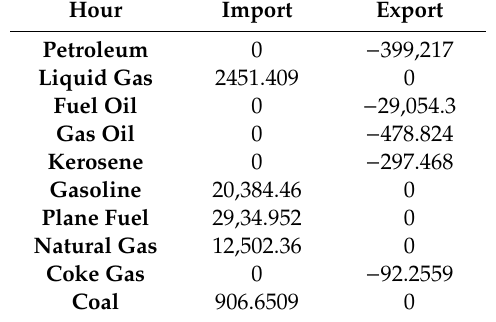
Figure 2. Convergence curve of doctor and patient optimization (DPO) on energy commitment (EC) solving. Table 8. Import and export of carriers Table 6. Appropriate combination of units and total cost for energy supply.